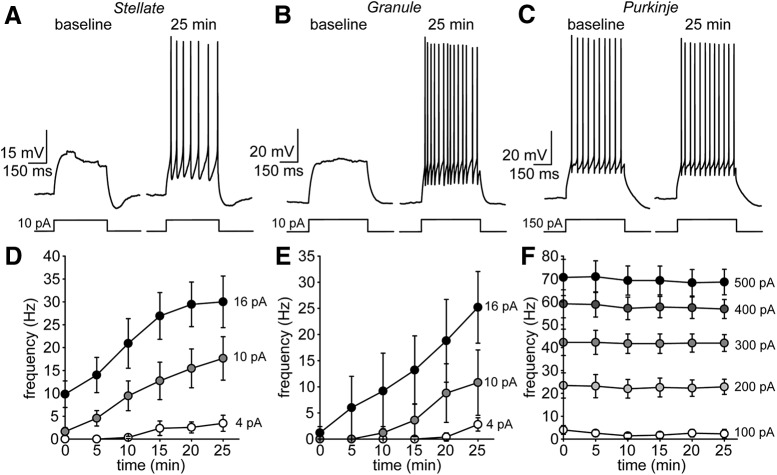

Stellate and GC (granule cell), but not Purkinje cells, exhibit excitability increases during whole-cell recording. A, Example SC current-clamp recording (patch #150129p2) applying a 10-pA step protocol shortly following breakthrough and after 25 min. B, C, Same for GC (patch #150324p2) and Purkinje cell (patch #141010p5) examples using 10- and 150-pA current steps, respectively. D, Summary SC AP frequency over 25-min recording for multiple step amplitudes (n = 11 cells). E, F, Same for granule (n = 6 cells) and Purkinje cells (n = 6 cells).